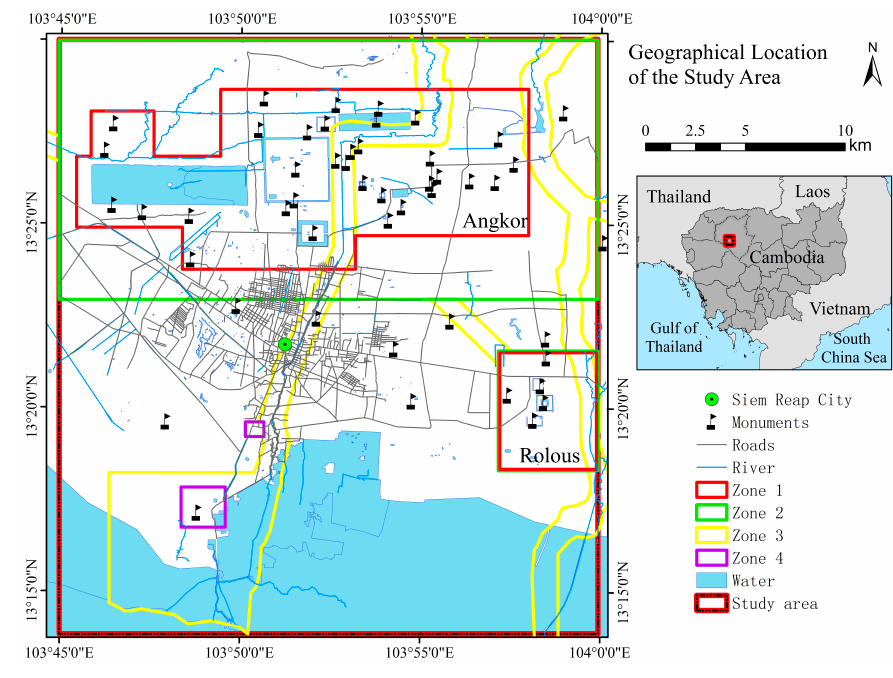
Figure 2. Map of the study